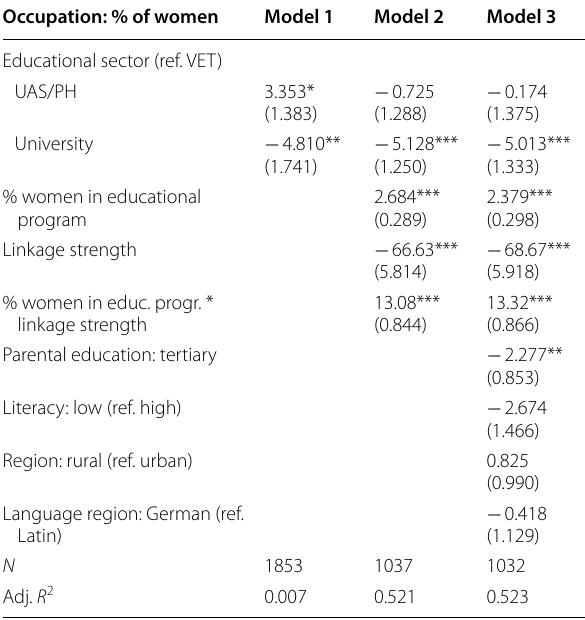
Table 8 Influence of educational gender concentration and linkage strength on